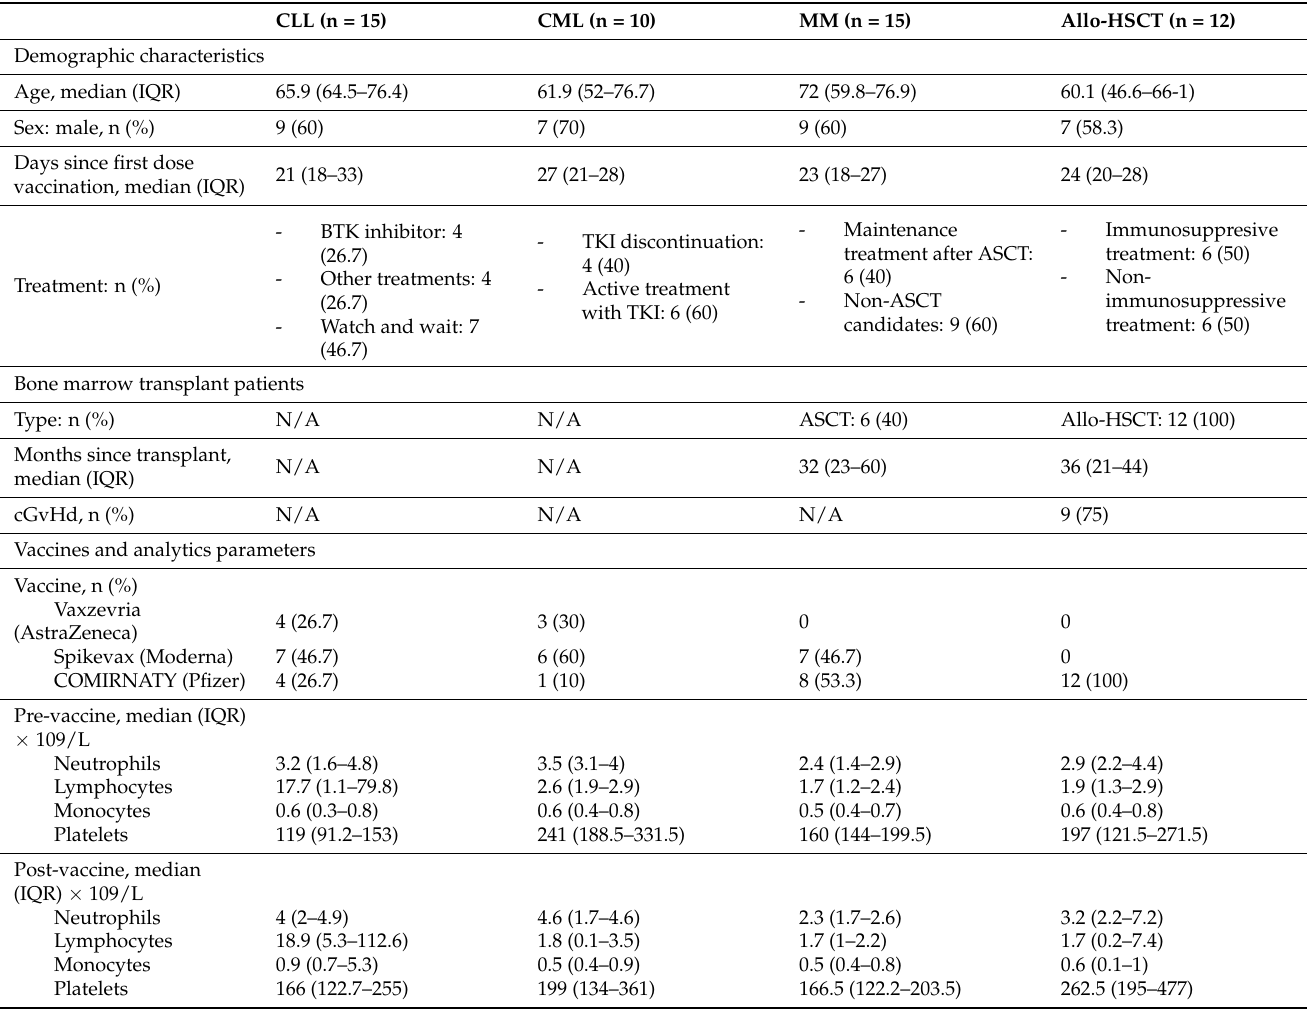
Table 1. Baseline demographic and clinical characteristics of the individuals with oncohematological diseases (OHD) recruited for this